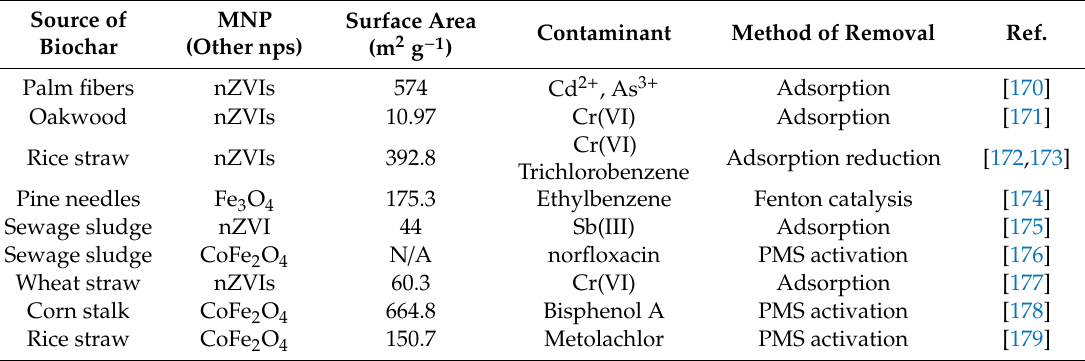
Table 9. Magnetic nanocomposites made with